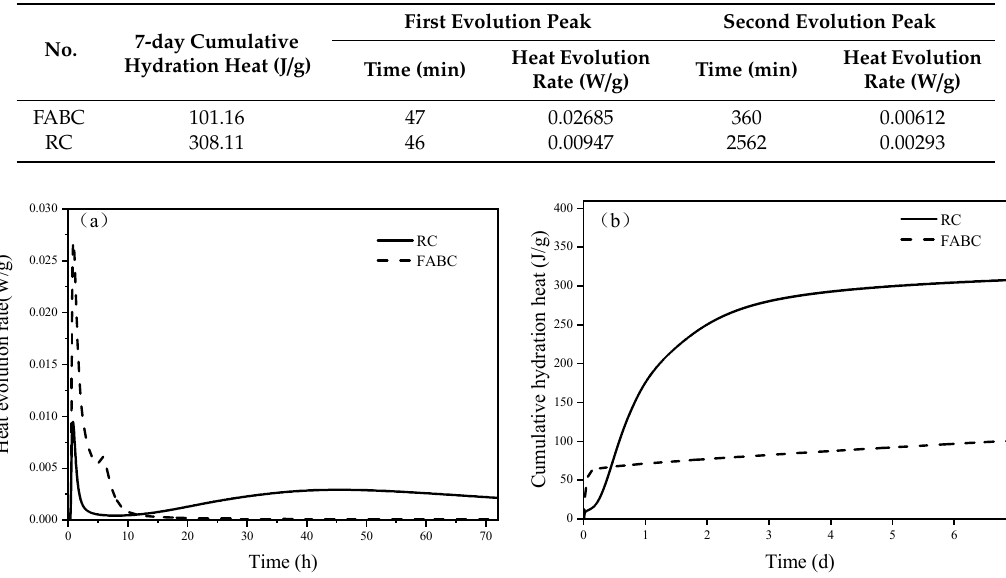
Figure 4. Heat evolution characteristics of FABC and RC: ( a ) Heat evolution rate; ( b ) Cumulative hydration